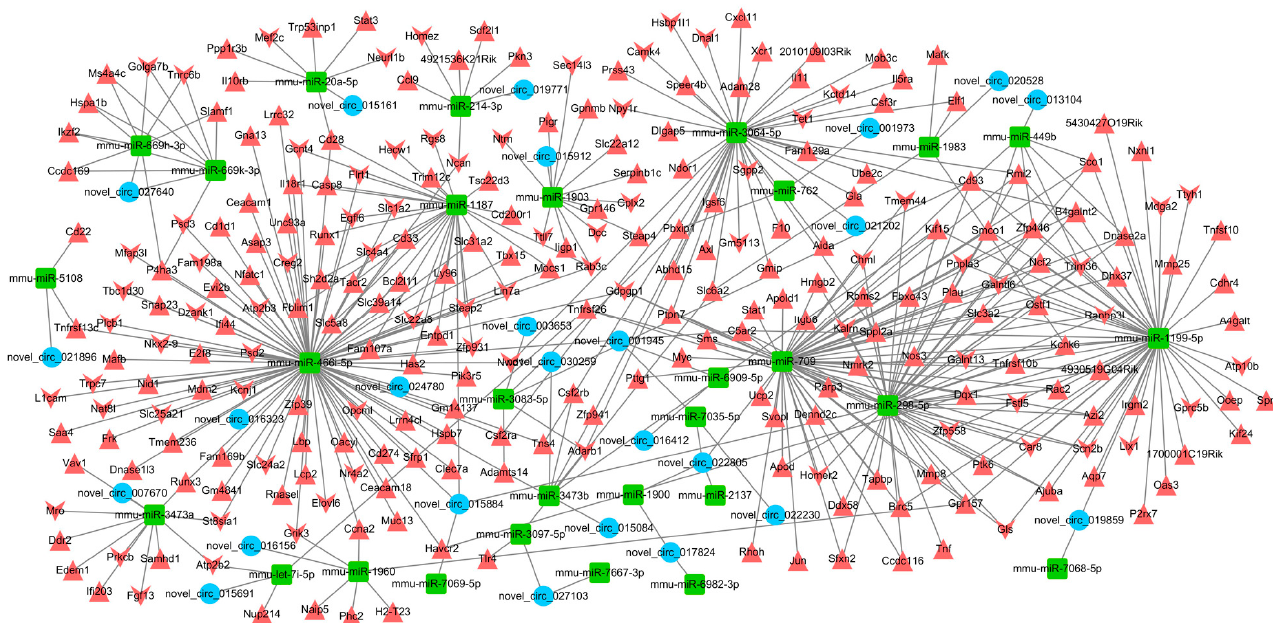
Figure 7. The circRNA–miRNA–mRNA interaction network. The blue circles represent circRNAs; the green rectangles represent miRNAs; the red upward triangles represent upregulated mRNAs, while the red downward triangles represent downregulated mRNAs. This network was visualized using Cytoscape software.